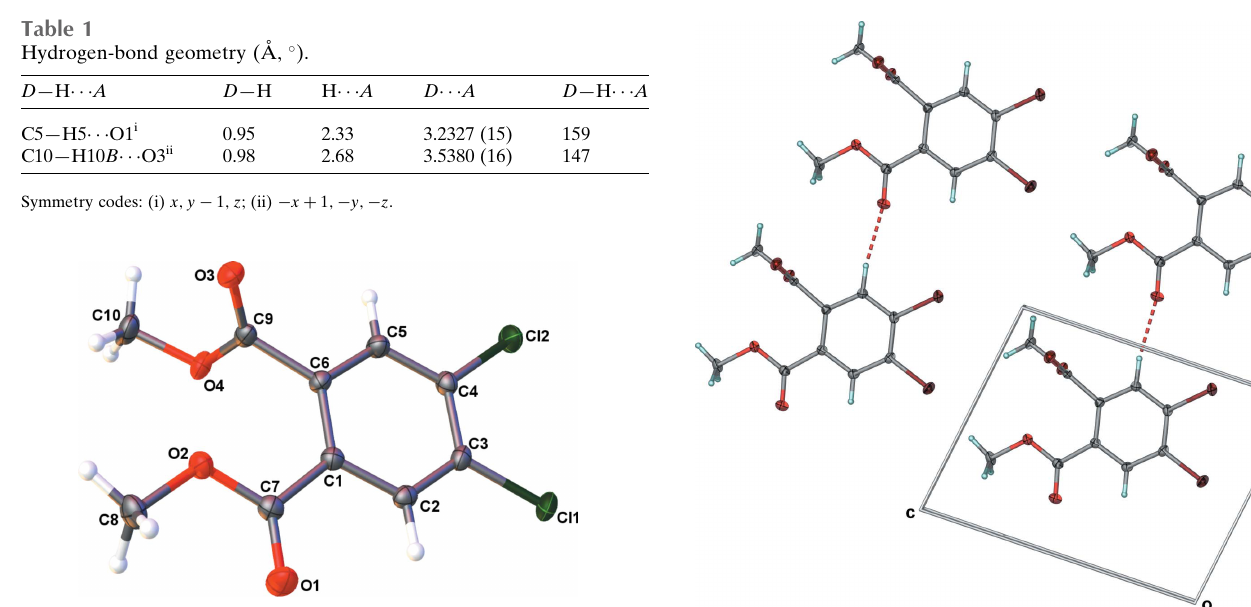
Figure 1 Anisotropic displacement ellipsoid plot of 1 with ellipsoids set to the 50% probability level.